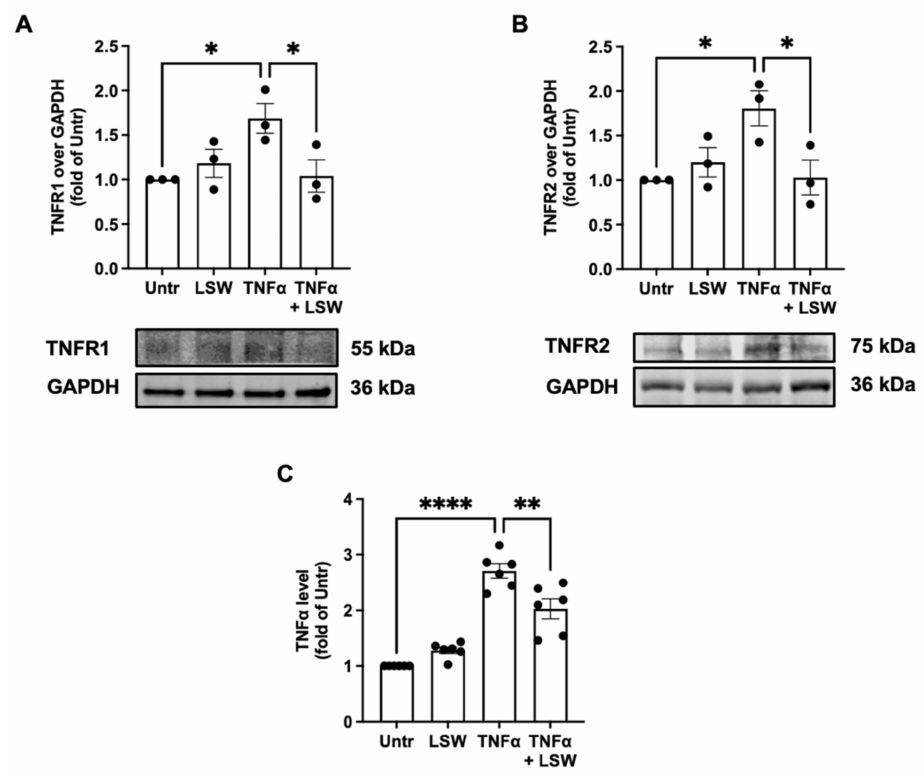
Figure 5. Effect of LSW treatment on TNFR1, TNFR2, and endogenous TNF α level in EA.hy926 cells. The cells were treated with LSW (50 µ M) for 18 h before TNF α (10 ng/mL) stimulation for 6 h. Protein bands of TNF α receptor 1 (TNFR1, ( A )) or 2 (TNFR2, ( B )) were normalized to GAPDH. ( C ) TNF α level (cell lysate) was measured using ELISA kit. Data were normalized to the untreated group (Untr). *, p < 0.05; **, p < 0.01; ****, p < 0.0001.